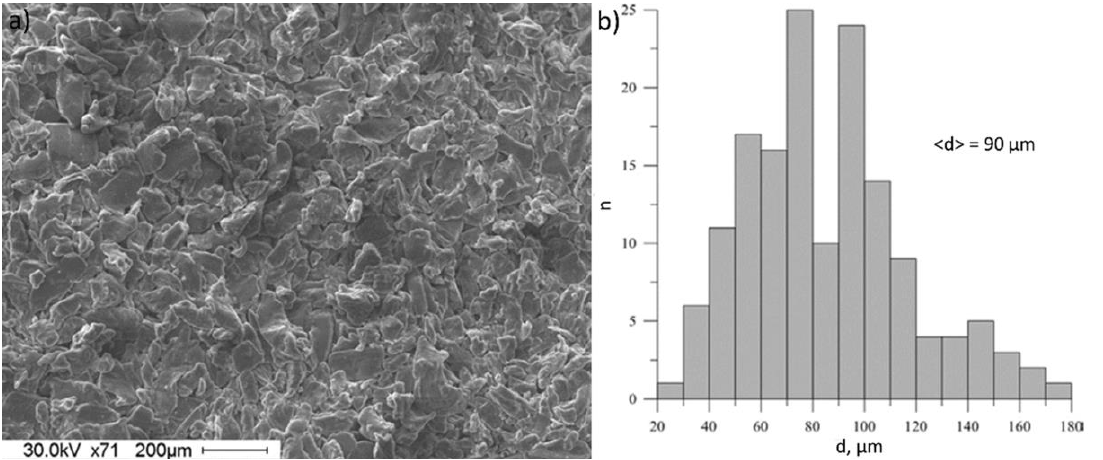
Figure 2. SEM image ( a ) and histogram of particle size distribution of the initial magnesium powder ( b ).